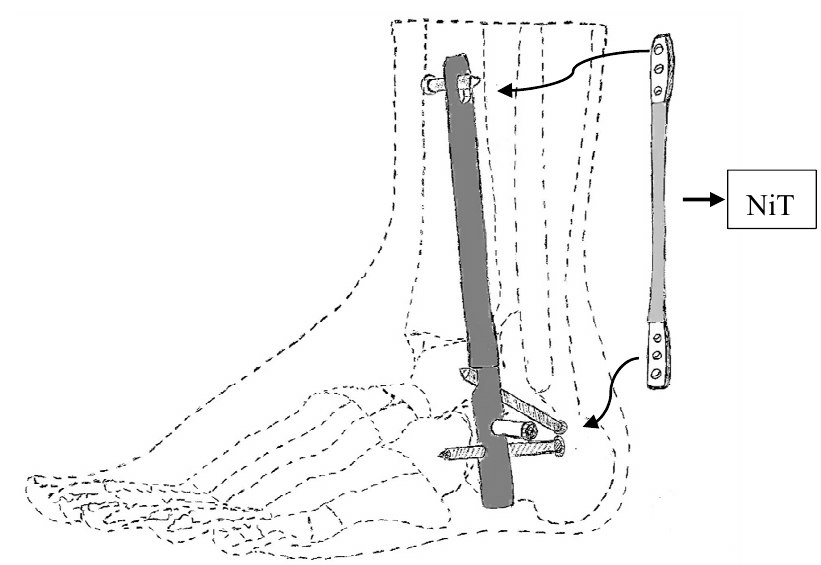
Figure 30. Arthrodesis device developed by Karnes et al. [59].